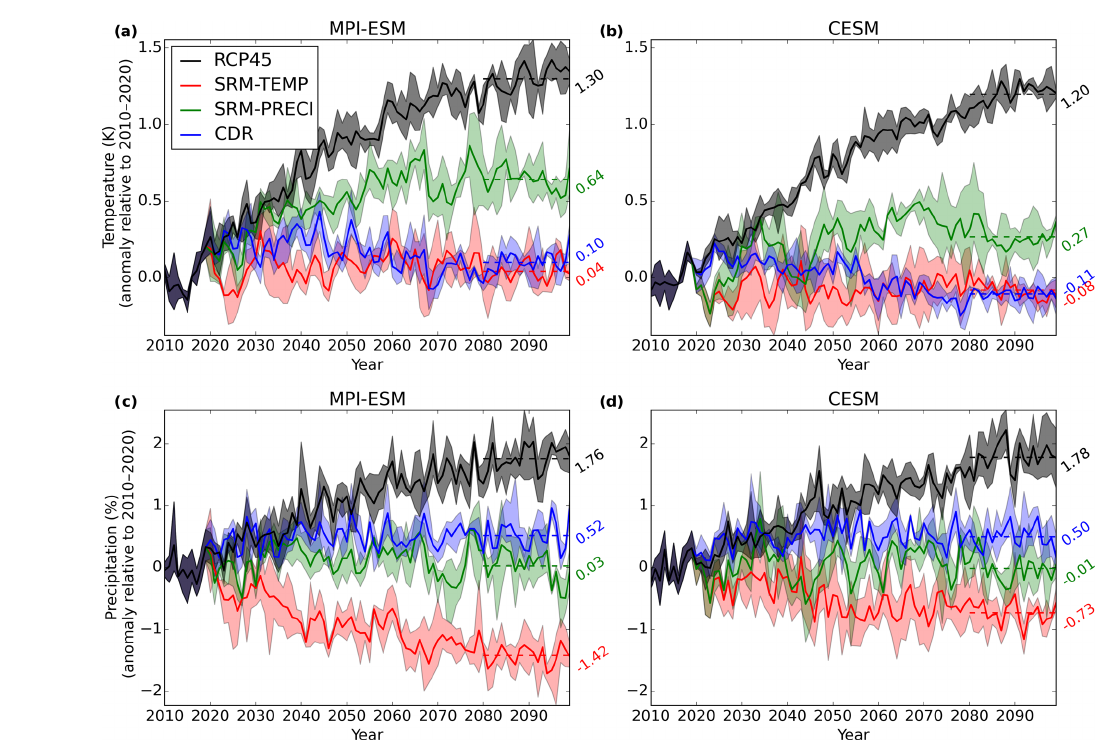
Figure 6. Global mean temperature anomalies in (a) MPI-ESM and (b) CESM, as well as global mean precipitation anomalies in (c) MPI- ESM and (d) CESM. Numbers to the right of each panel indicate the global mean difference between 2080–2100 and 2010–2020. Shaded areas show the maximum and minimum across three ensemble